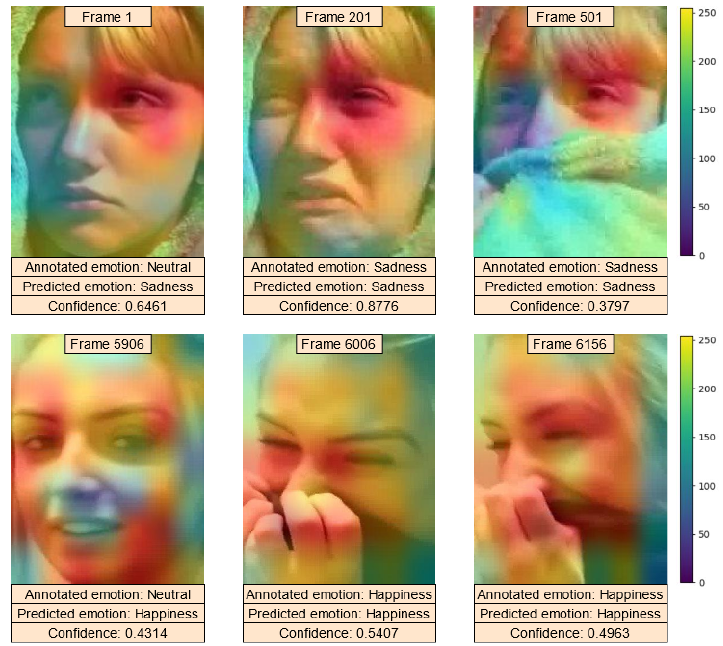
Figure 8. GradCAM-based saliency maps for predicted classes by AffWild2-EE.